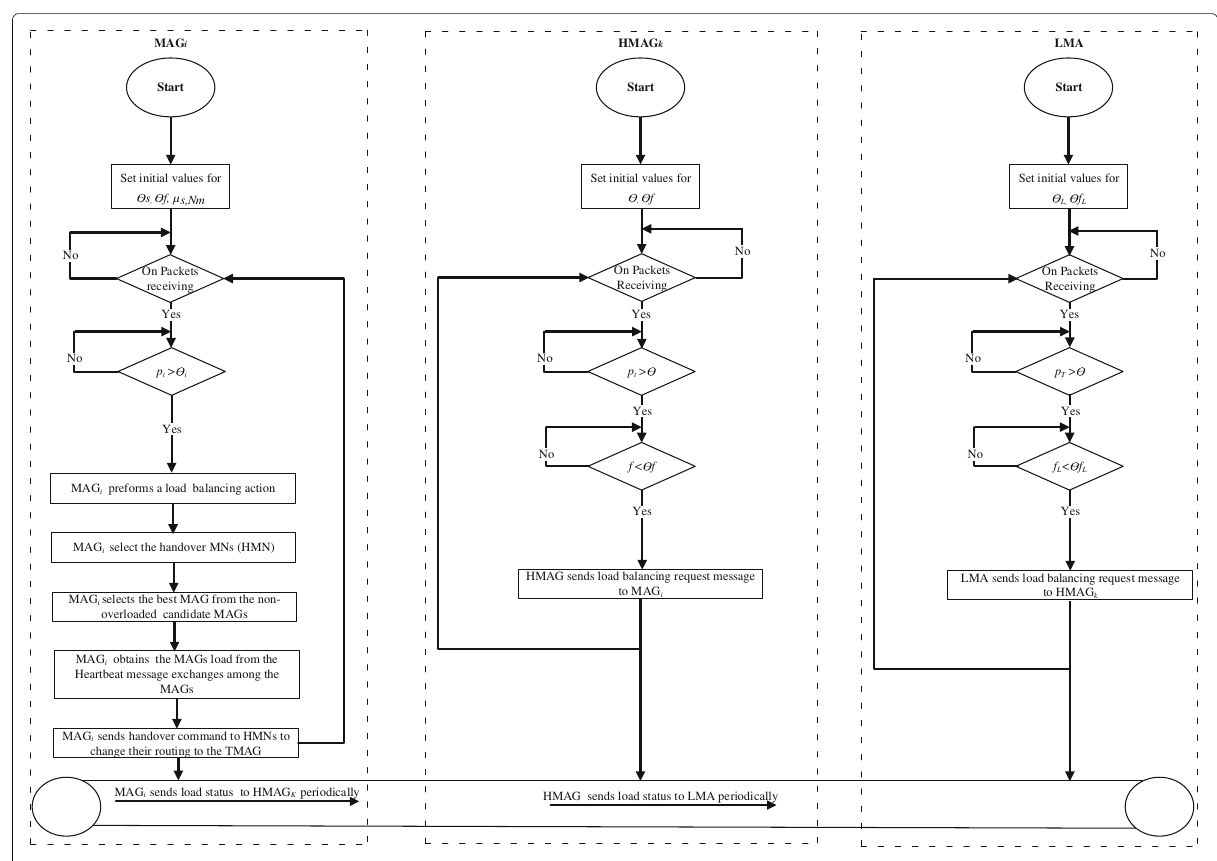
Fig. 6 Load balancing operations within CSPMIPv6